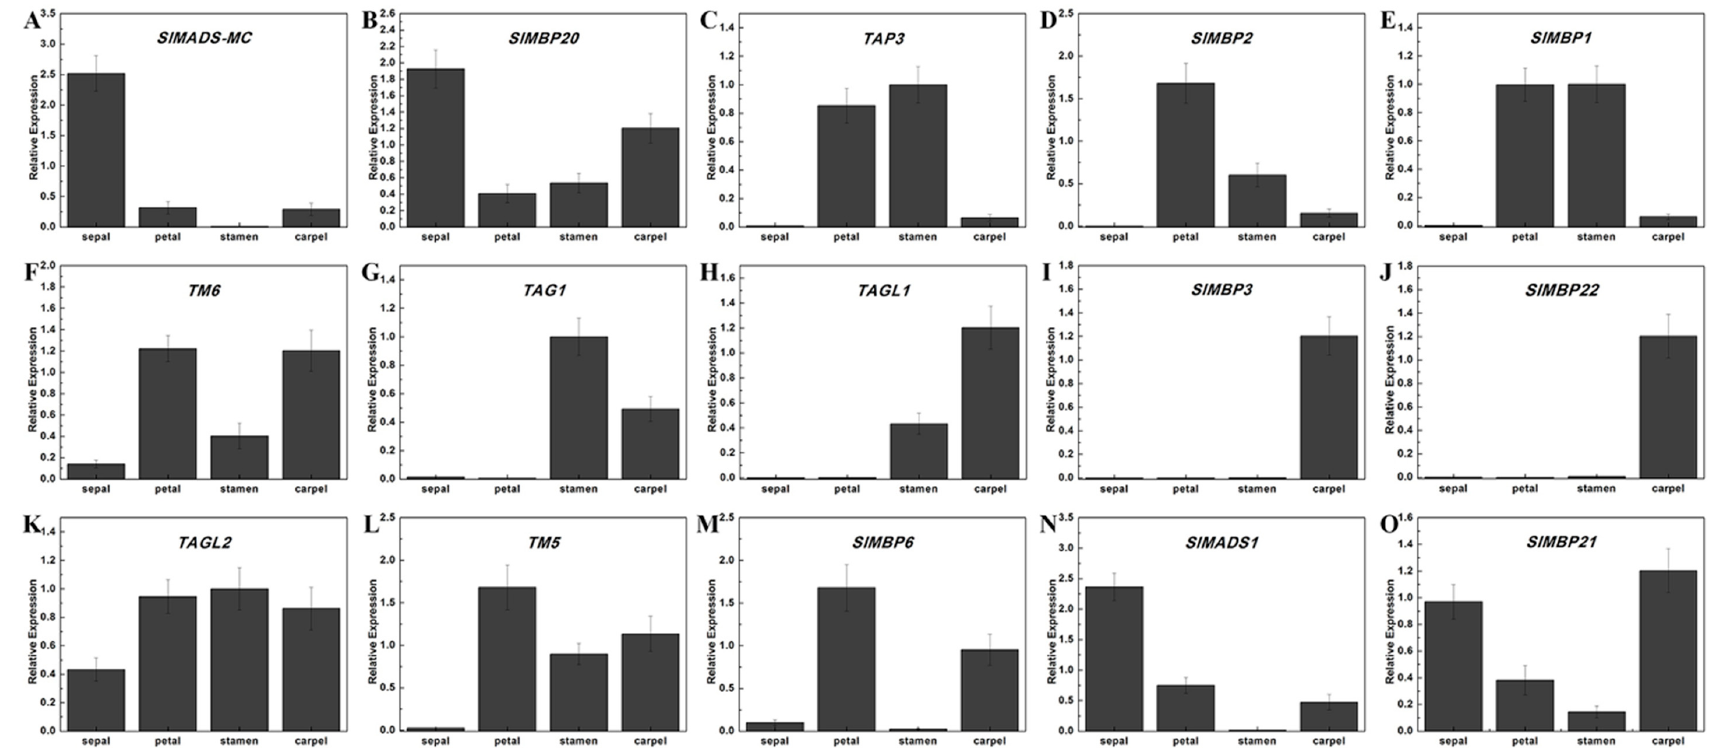
Figure 5. Expression profiles of floral organ identity genes in the four-whorl floral organs of the wild-type (WT) tomato plant for qPCR analysis. Se, sepal; Pe, petal; St, stamen; Ca, carpel. (A)–(O) Expression profiles of SlMADS - MC , SlMBP 21 , TAP3 , SlMBP2 , SlMBP1 , TM6 , TAG1 , TAGL1 , SlMBP3 , SlMBP22 , TAGL2 , TM5 , SlMBP6 , SlMADS1 and SlMBP21 .Each value represents the mean ± SE of three technical replicates of a single biological sample. The SlCAC gene of tomato was used as the internal standard.